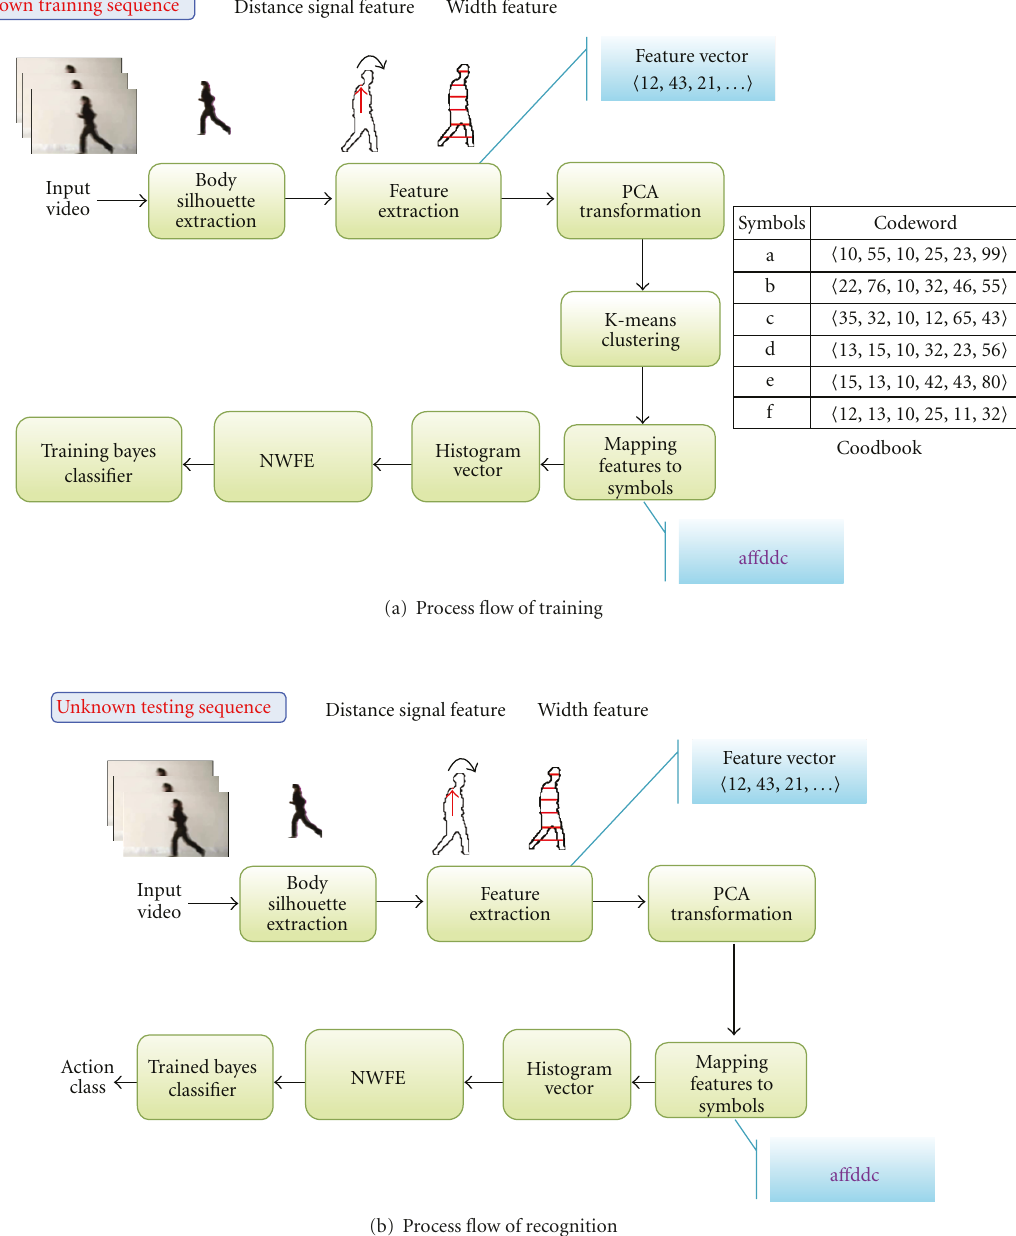
Figure 1: Flowchart of the proposed